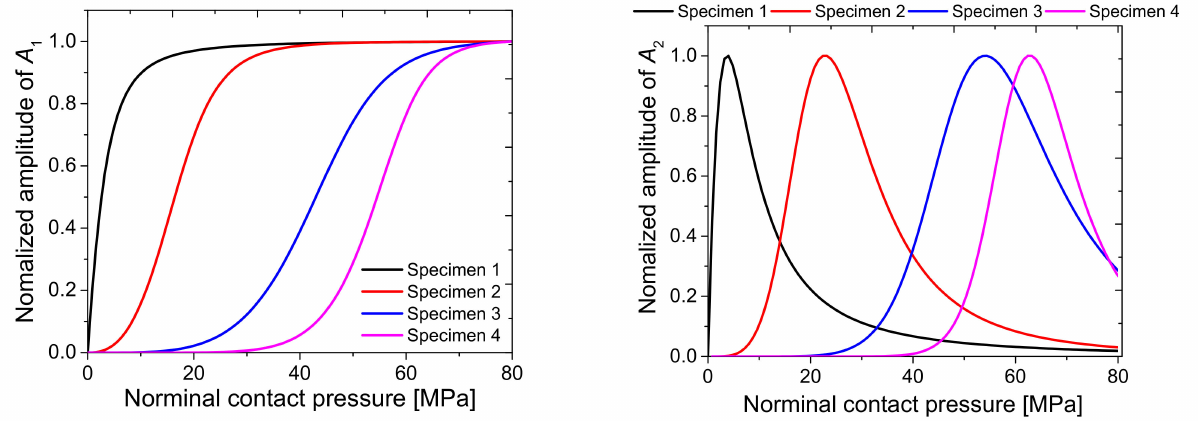
Figure 2. Theoretical simulations of A 1 and A 2